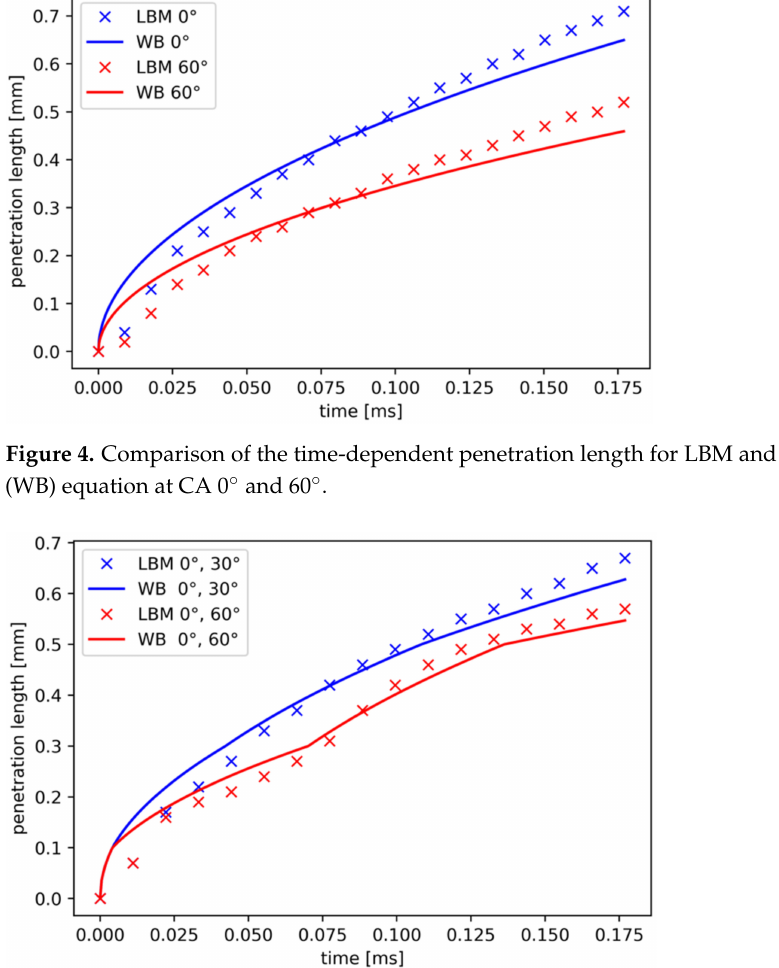
Figure 5. Comparison of the time-dependent penetration length for LBM and analytical Washburn equation with alternating CA coating for the CA pairs: 0 ◦ and 30 ◦ as well as 0 ◦ and 60 ◦ with an equidistant strip width of 0.2